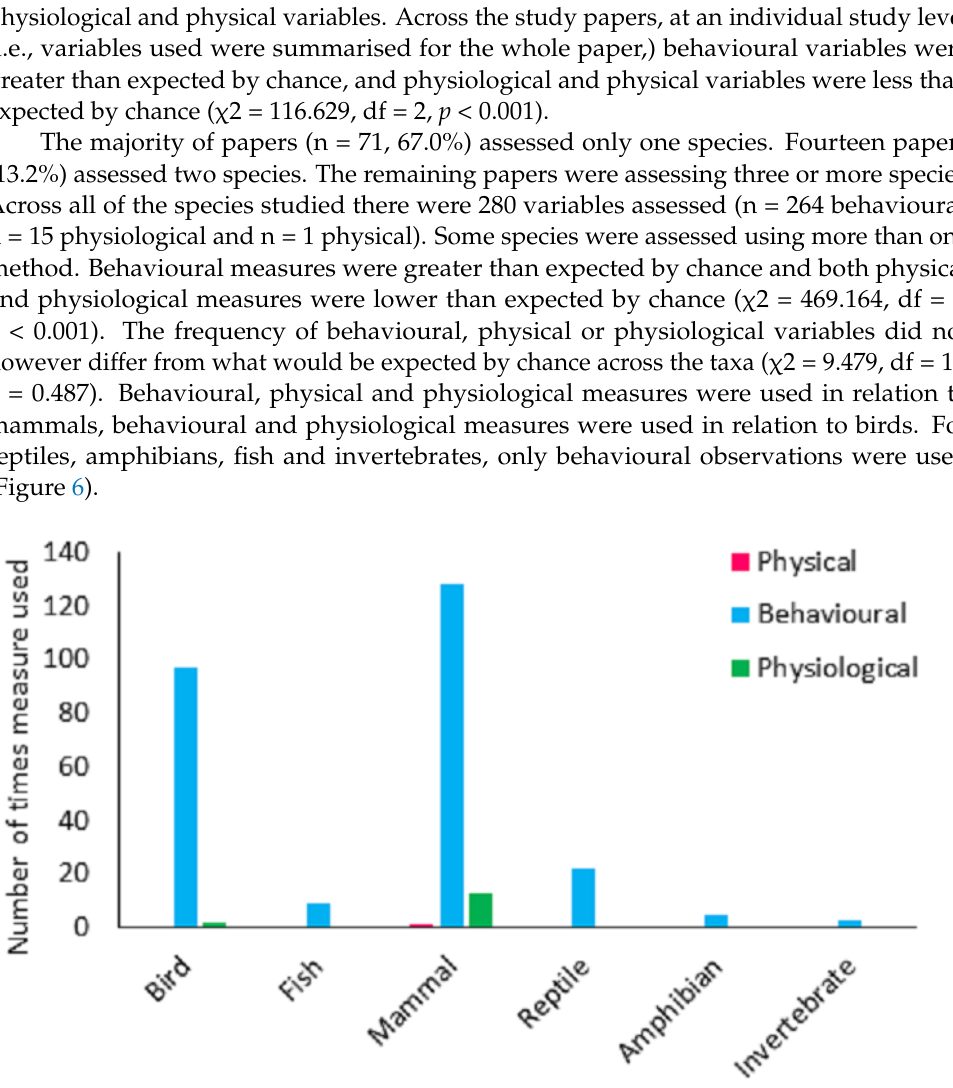
Figure 6. A breakdown of the number of behavioural, physical and physiological animal-based measures and how they varied across the animal groups.